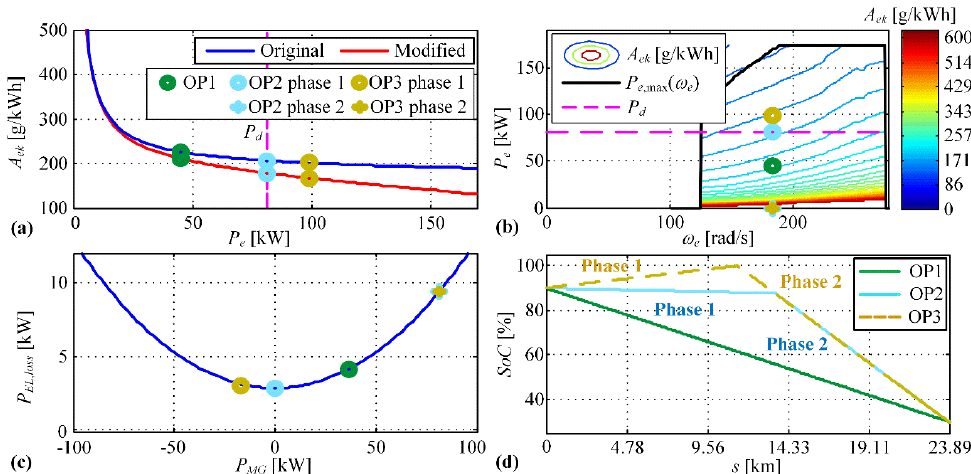
Figure 12. Illustration of three different operating scenarios through engine mean specific fuel consumption ( a ), engine power ( b ), total electric energy losses ( c ), and SoC trajectory profile ( d ) (the same operating conditions as in Figure 11: SoC = 50%, v v = 86 km / h, ω e = ω MG = 184 rad / s, P d = 79.7 kW).